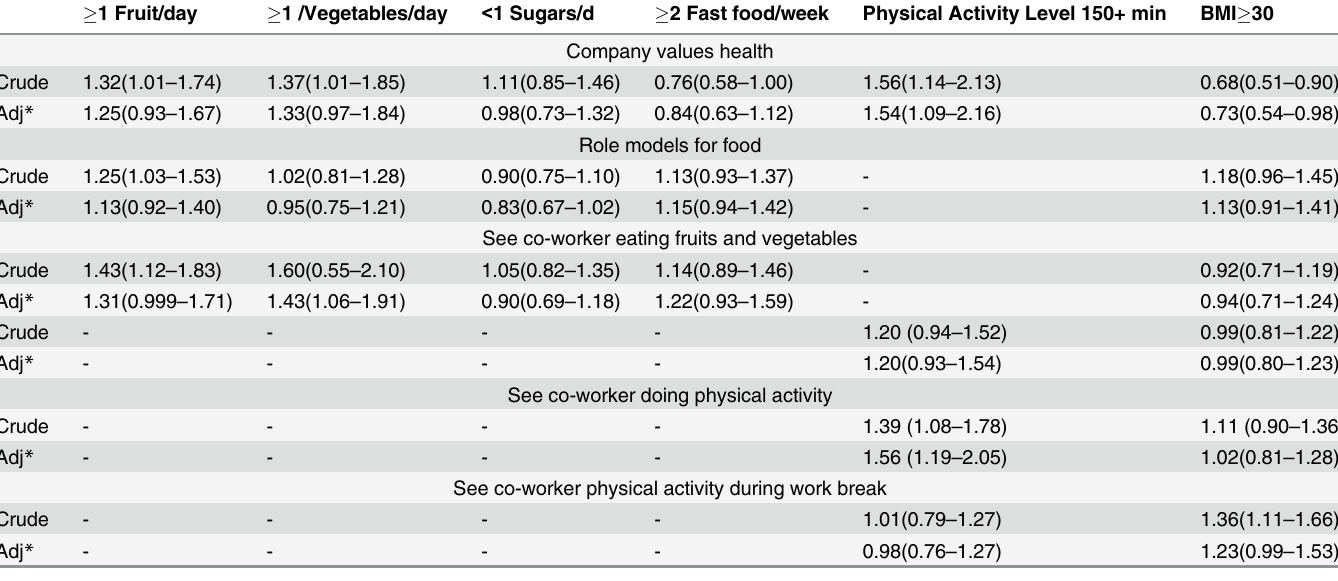
Table 2. Crude and adjusted * logistic regression of diet, physical activity, and obesity variables and social/organizational variables OR (95% CI), Missouri, USA n = 1,338. (cid:1) 1